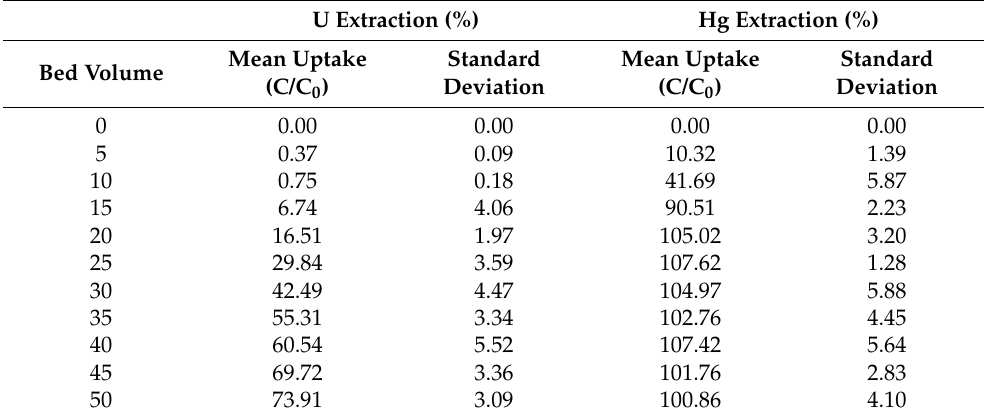
Table 5. U and Hg extraction in a continuous mode (SCRWL = KI 0.15 M; BV = 12 mL; Flow rate = 3 BV/h) in triplicate (mean uptake and standard